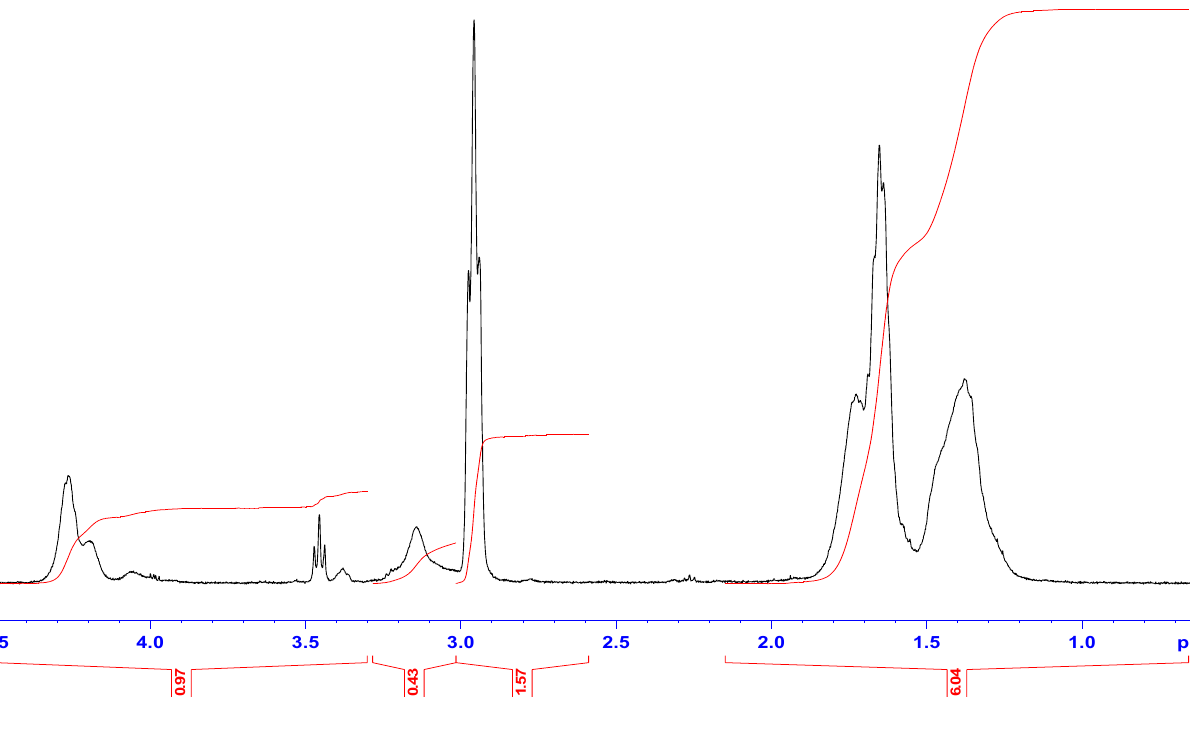
Figure 3. NMR spectrum of DGL G3 in D